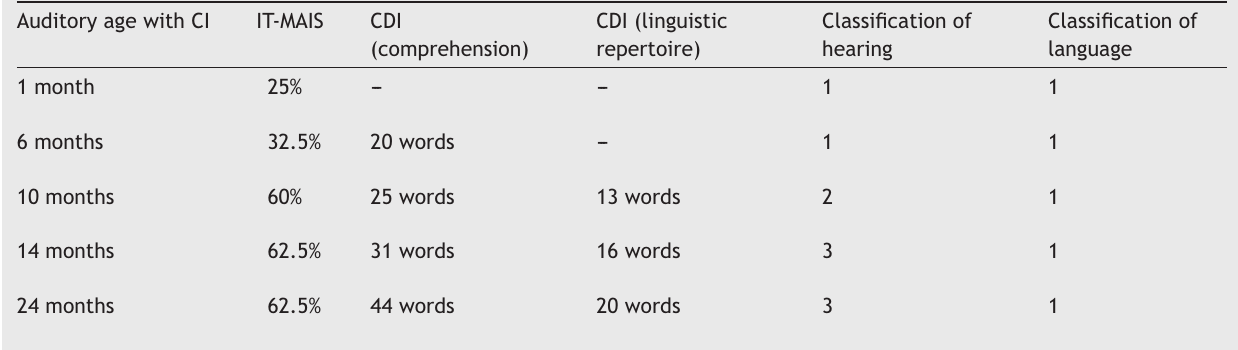
Results of IT-MAIS and CDI tests and classifications of hearing and language of participant A. Auditory age with CI